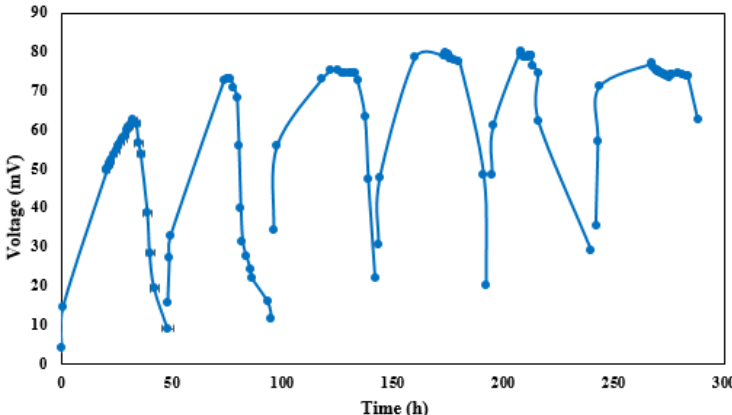
Figure 3. Time course of voltage during the first six cycles of MFC operation.